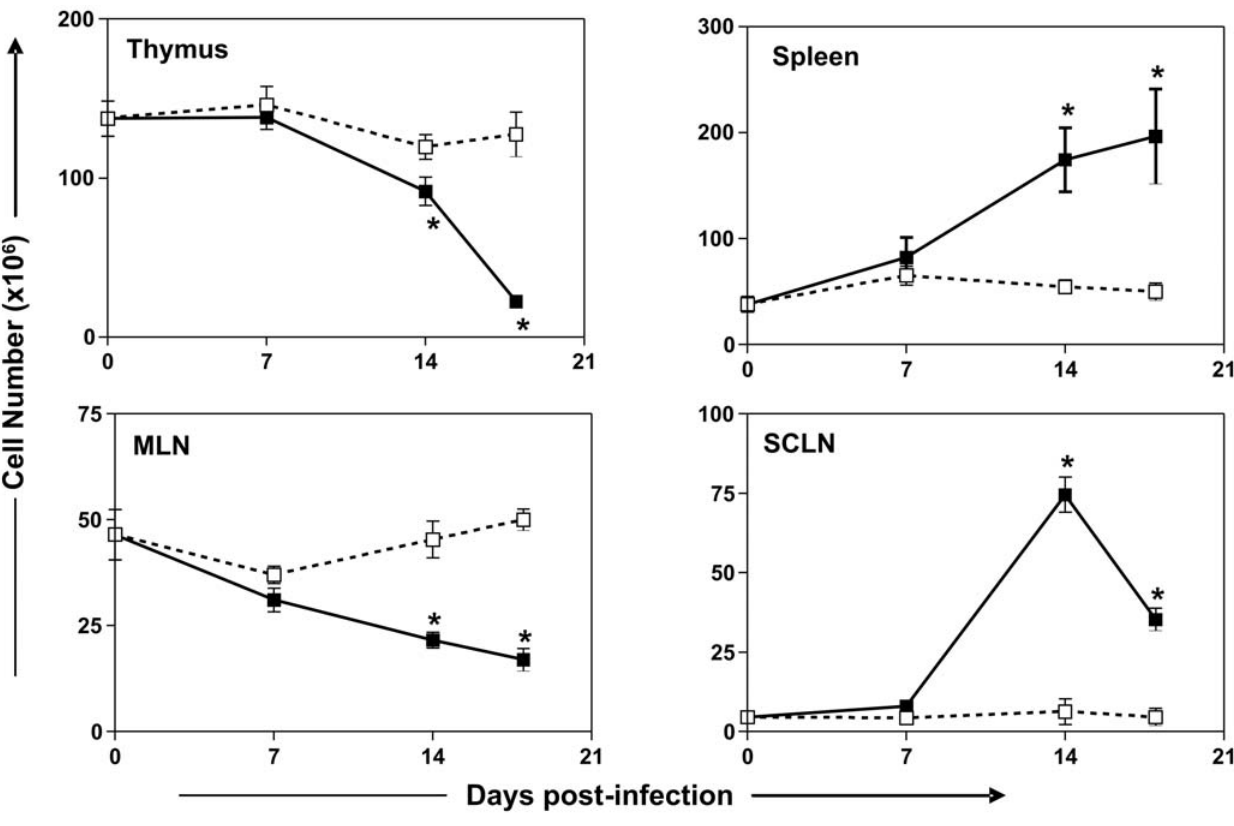
Figure 1. Differential fluctuations in the cellularity of the thymus, spleen, MLN, and SCLN in the course of acute T.cruzi infection. Note a lymphocyte expansion in the spleen and SCLN, in parallel to a lymphocyte decrease in the thymus and MLN. BALB/c mice were infected intraperitoneally with 10 2 blood trypomastigotes of the Tulahue´n strain, killed at different days of infection, and cell numbers evaluated by trypan blue exclusion. Erythrocytes were previously depleted in the spleen cell suspensions by treatment with Tris-buffered ammonium chloride. Values represent the mean 6 standard error; n =3–5 mice/group in each point. Data recorded on thymus, spleen, MLN, and SCLN from T. cruzi -infected mice (closed squares) were compared to non-infected age-matched controls (open squares) with ANOVA statistical test, using the program SigmaStat (Statistical Software) for Windows. Data were considered significant if p values were , 0.05. Data represent mean 6 standard error. All experiments and animal handling were conducted according to protocols approved by the Oswaldo Cruz Foundation Committee on the Use of